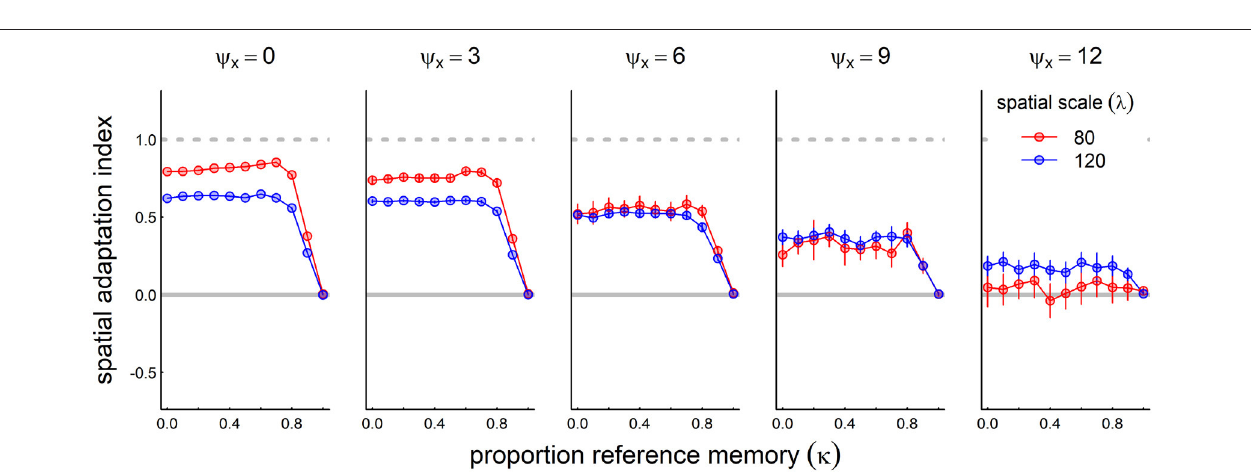
FIGURE 8 | Role of reference memory in adapting to climate change for increasingly stochastic resource dynamics. We ran the model with a moderate rate of climate change (mean shift: 0.5/year) at five increasing levels of stochasticity (inter-annual standard deviation of resource peak 0, 3, 6, and 12, left to right panels). For non-zero stochasticity, we ran the process 30 times and present the mean and standard error of the spatial adaptation index across various values of the reference memory parameter κ : where κ 0, the system modifies its migration based entirely on recent experiences; at κ 1, the memory never changes from the reference = = memory. Other parameter values are resource following α 100, social attraction β 400, and diffusion ε = = =